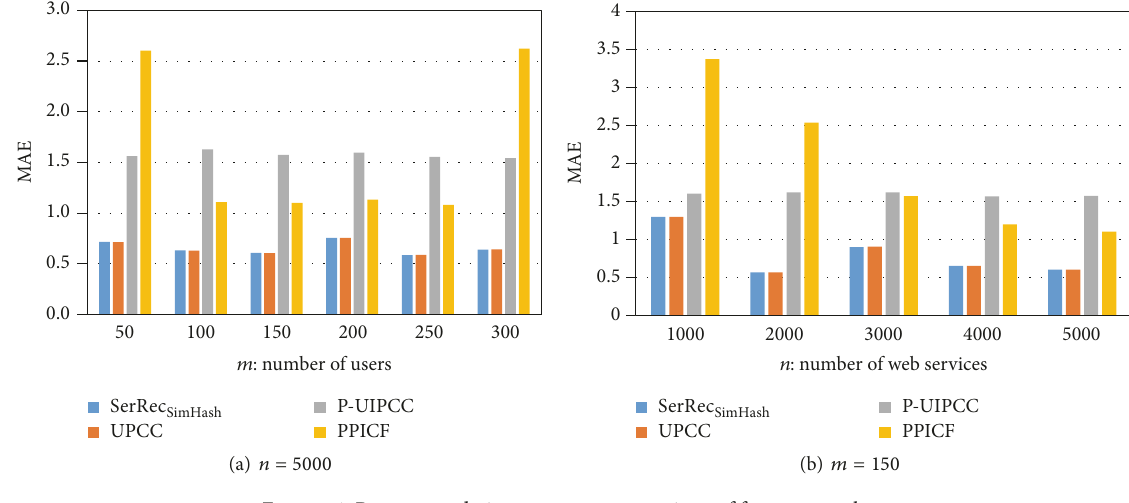
Figure 4: Recommendation accuracy comparison of four approaches.